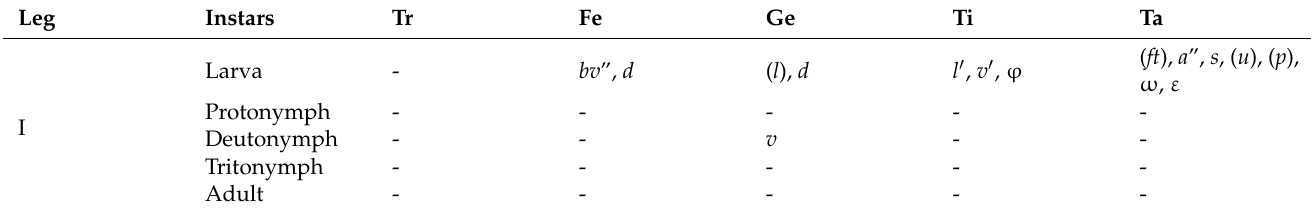
Figure 4. Paralycus daeira sp. n., female: ( A )—leg I, right, dorsal view; ( B )—tarsus I, right, ventral view; ( C )—leg II, left, dorsal view; ( D )—leg III, left, paraxial view; ( E )—leg IV, left, paraxial view; ( F )—genitals; ( G )—palp, left, dorsal view. Scale bar 50 µm ( A – F ), 10 µm ( G ). Table 1. Ontogenetic development of leg setae and solenidia (first appearance) in Paralycus daeira sp.